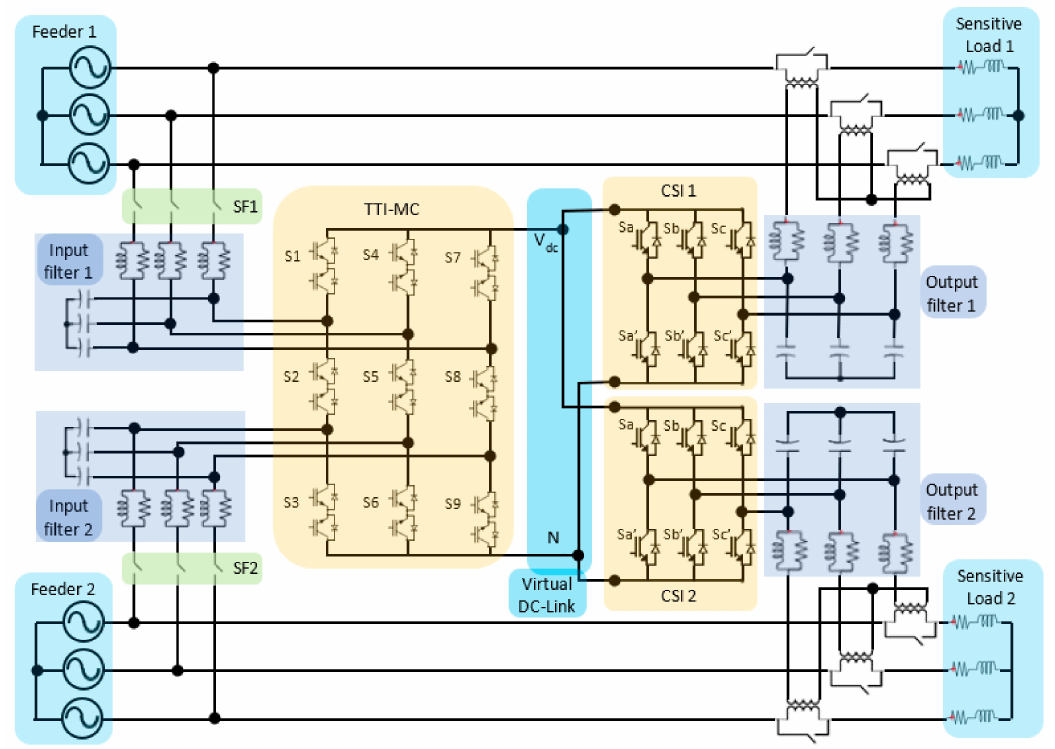
Figure 2. Schematic diagram of the proposed two input interline dynamic voltage regulator (TI-IDVR). CSI: current source inverter; TTI-MC: two three-phase input matrix converter. Where, SF are the switches that connect and disconnect the feeders and Sn are the switching elements of the TTI-MC and the CSIs, with n = 1, 2 ... and n = a, b, c,